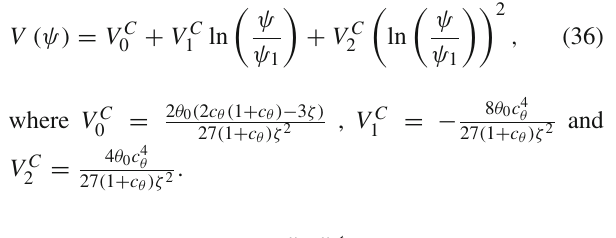
For ψ 2 = 0 , it follows